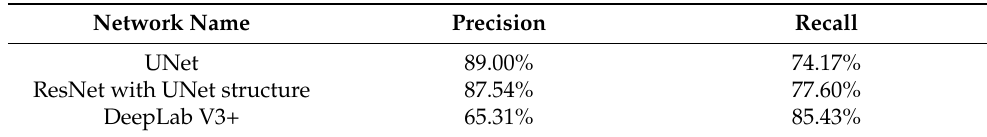
Table 1. Results of model evaluation of EMI label